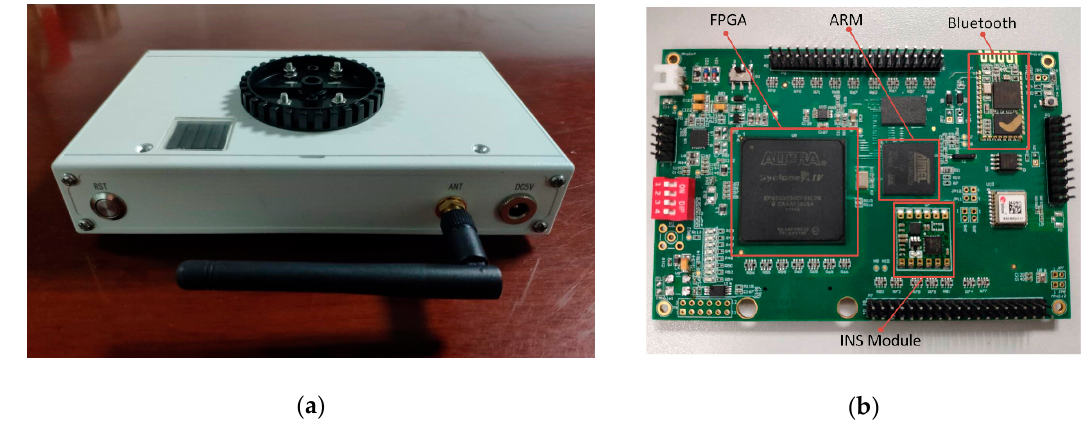
Figure 18. ( a ) External structure of CNFS positioning receiver; ( b ) internal structure of CNFS positioning receiver.